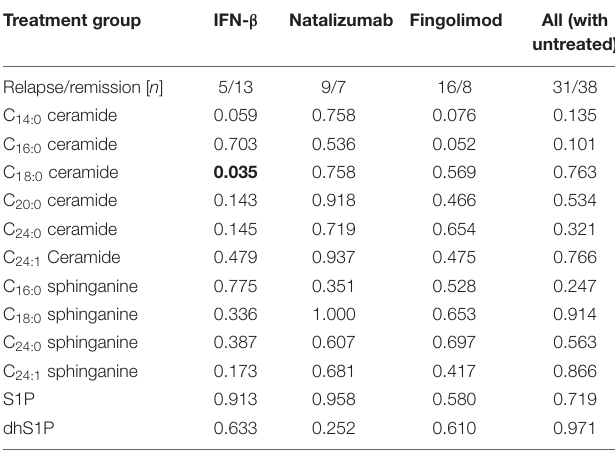
TABLE 2 | RRMS patients in remission and in relapse reveal no obvious differences in plasma sphingolipid concentrations. Treatment group